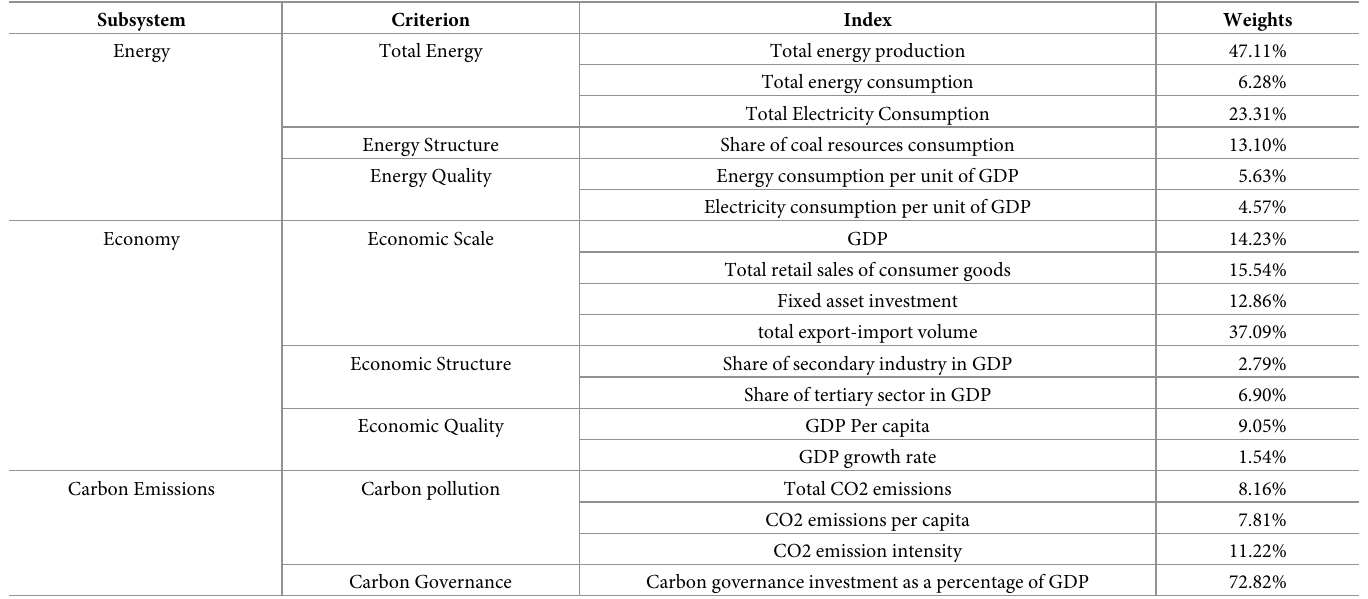
Table 1. Index appraise system of coupling coordination development of energy-economy-carbon emissions.